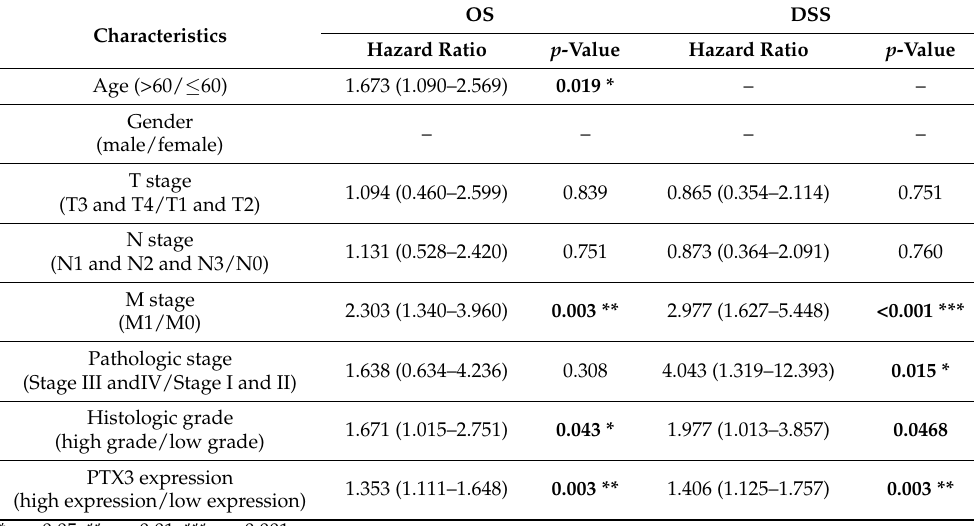
Table 2. Multivariable Cox regression of PTX3 and clinical features of KIRC in